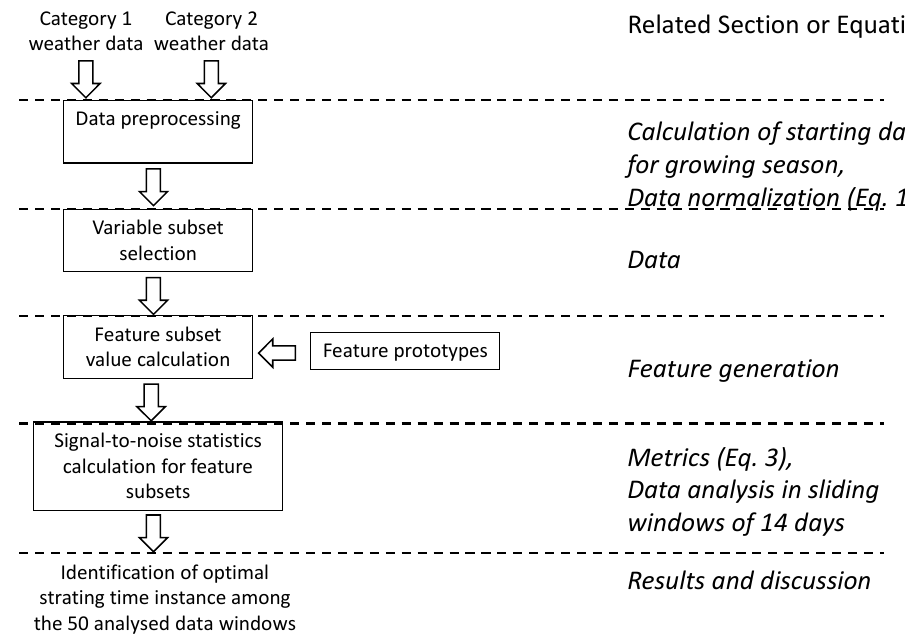
Figure 1. Analysis procedure for meteorological data to identify time instance of optimal information content concerning forecasting the severity of net blotch occurrence.